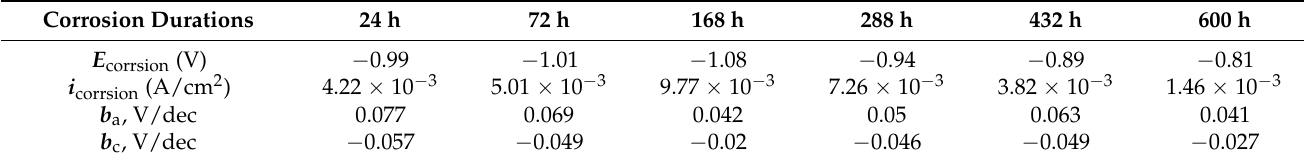
Figure 10. Electrochemical polarizations of test steels after corrosion for different times: ( a ) polarization curves; ( b ) variation of corrosion current density and corrosion potential with time. Table 2. Electrochemical parameters corresponding to polarization curve.